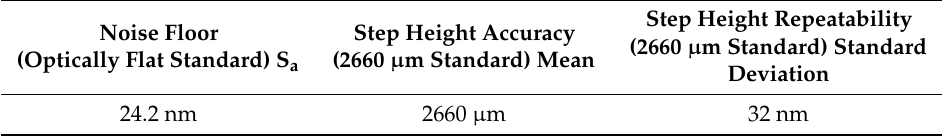
Table 2. Summary of key system performance on traceable standards.